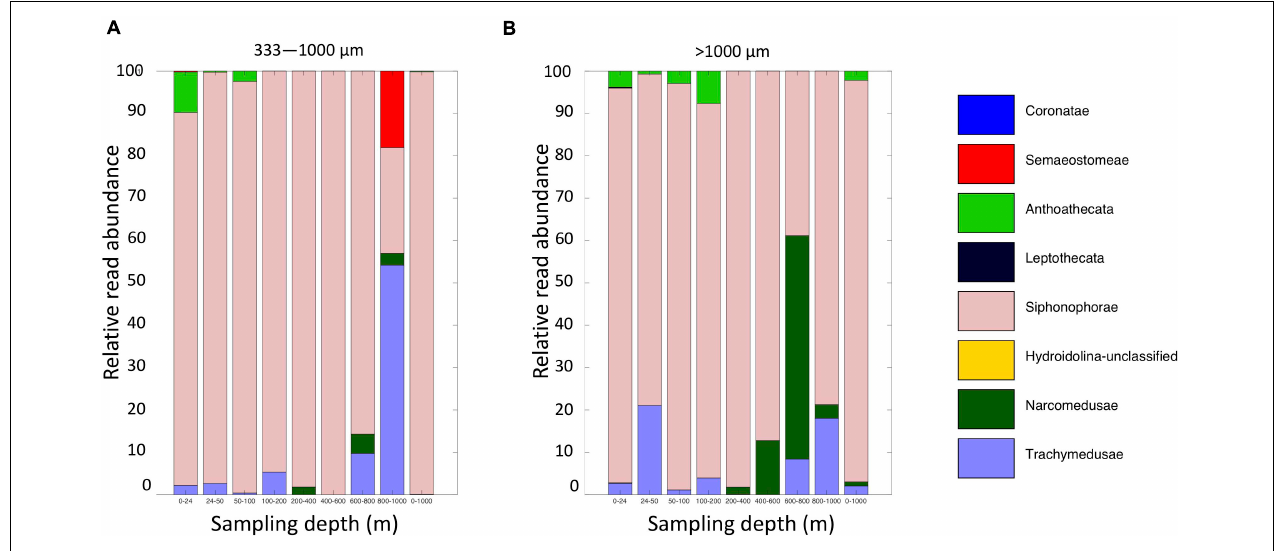
FIGURE 11 | Relative read abundances of Level 6 taxa identified as Medusozoan (Scyphozoa, Hydroidolina, Anthoatheca, Leptotheca, and Trachylinae). (A) MOCNESS small size fraction. (B) MOCNESS large size fraction.